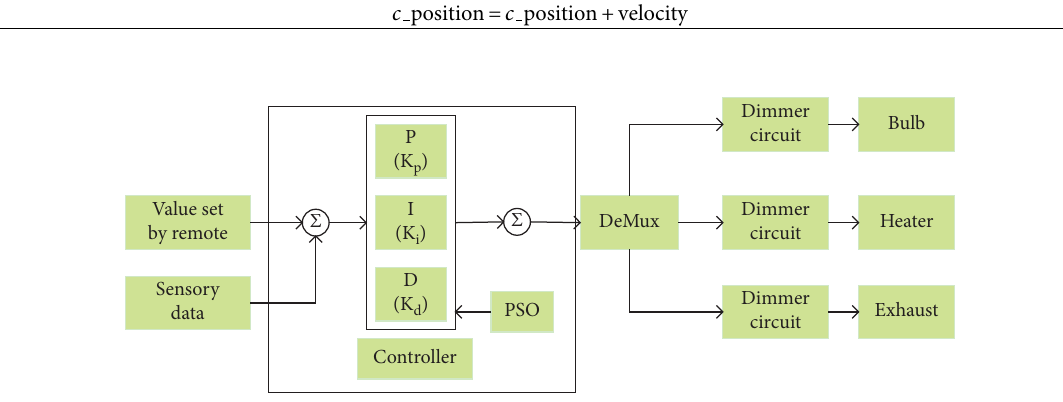
Figure 6: PSO with PID controller for home